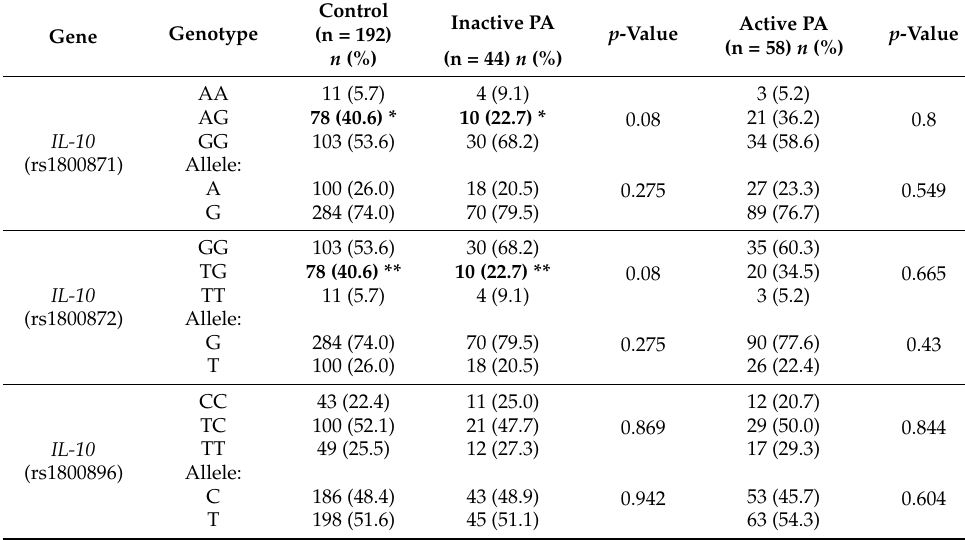
Table 2. Distributions of IL-10 rs1800871, rs1800872, rs1800896 genotypes and alleles in patients with PA and control groups by PA activity.